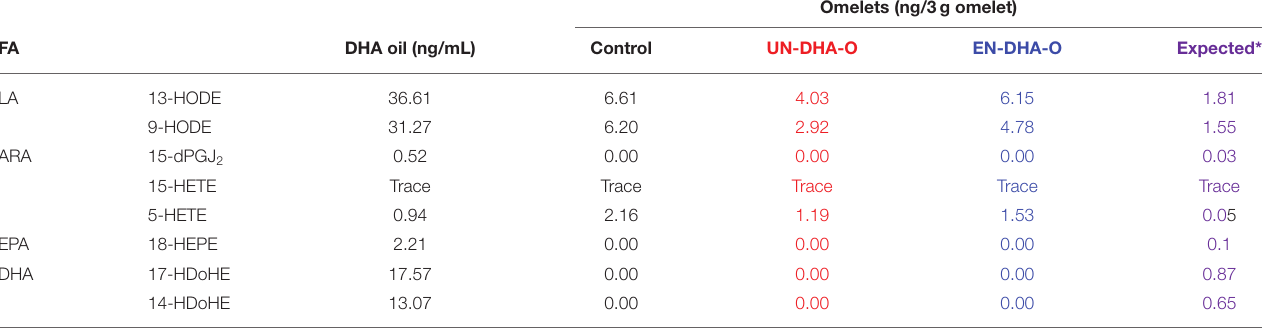
TABLE 5 | The oxidized derivatives of fatty acids from DHA oil and